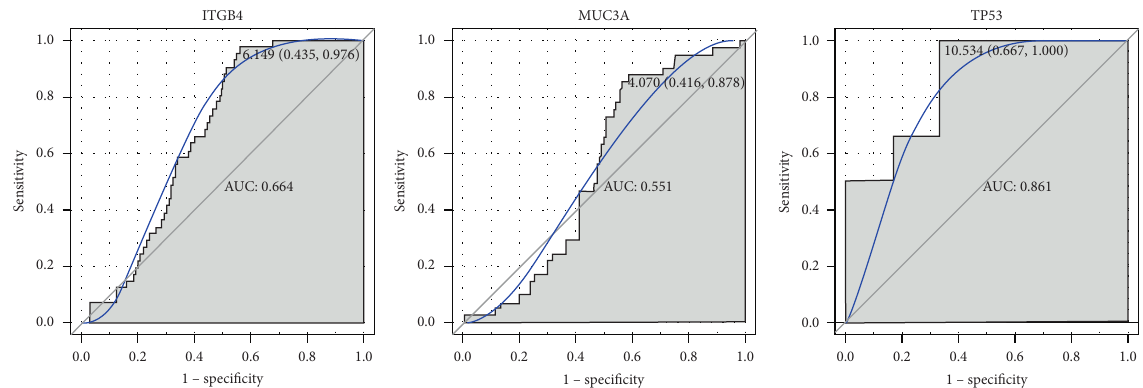
Figure 9: The ROC curves of ITGB4 and MUC3A in UC and PSC and TP53 in SSA.